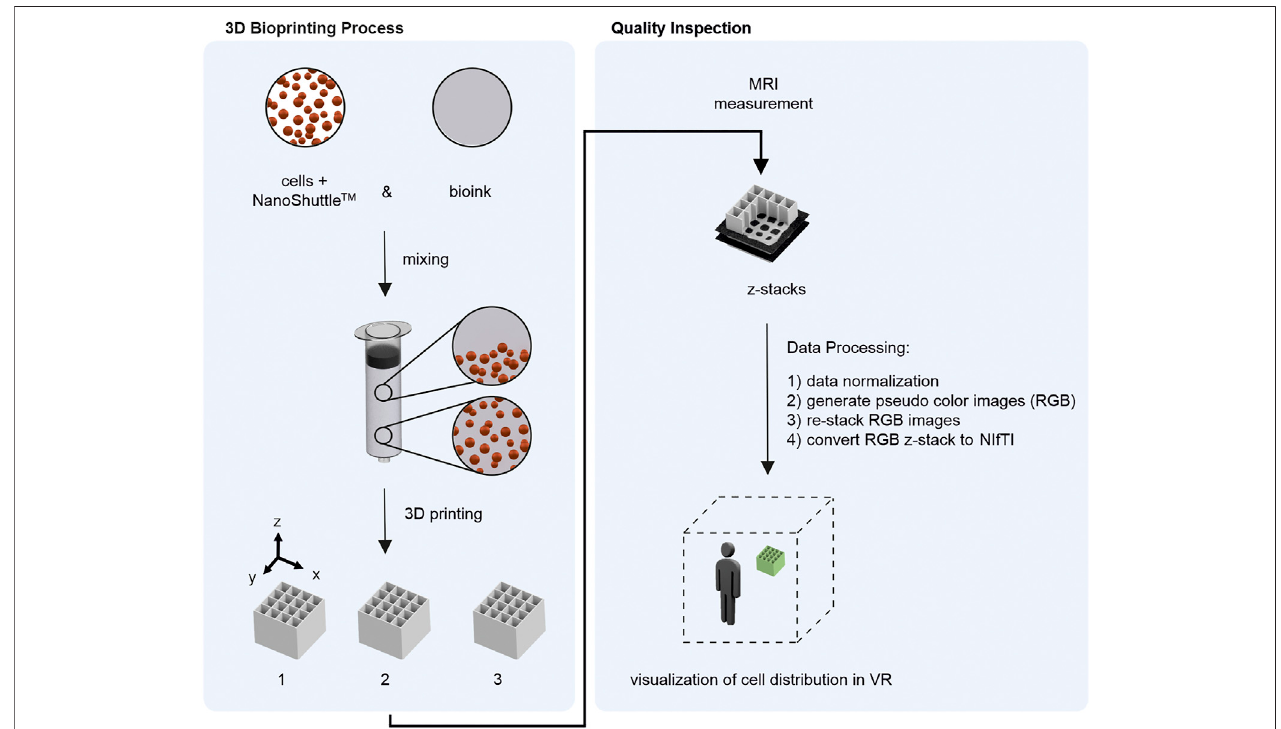
FIGURE 1 | Overview of the developed work fl ow. Left) 3D Bioprinting process including mixing magnetically tagged cells (using NanoShuttle ™ ) with bioink and consecutive 3D printing of the material to cubes. Bioprinting was done with 3.3 ml bioink-cell-mixture resulting in 3 objects per run. The experiment was performed 4times ( n =4)resultingin3×4=12samplesforquality inspection. Right)QualityInspectionstartingwithMRImeasurementofeachsampleresultinginz-stackswith15 axial slices. After four steps of data processing the MRI data could be inspected in a VR